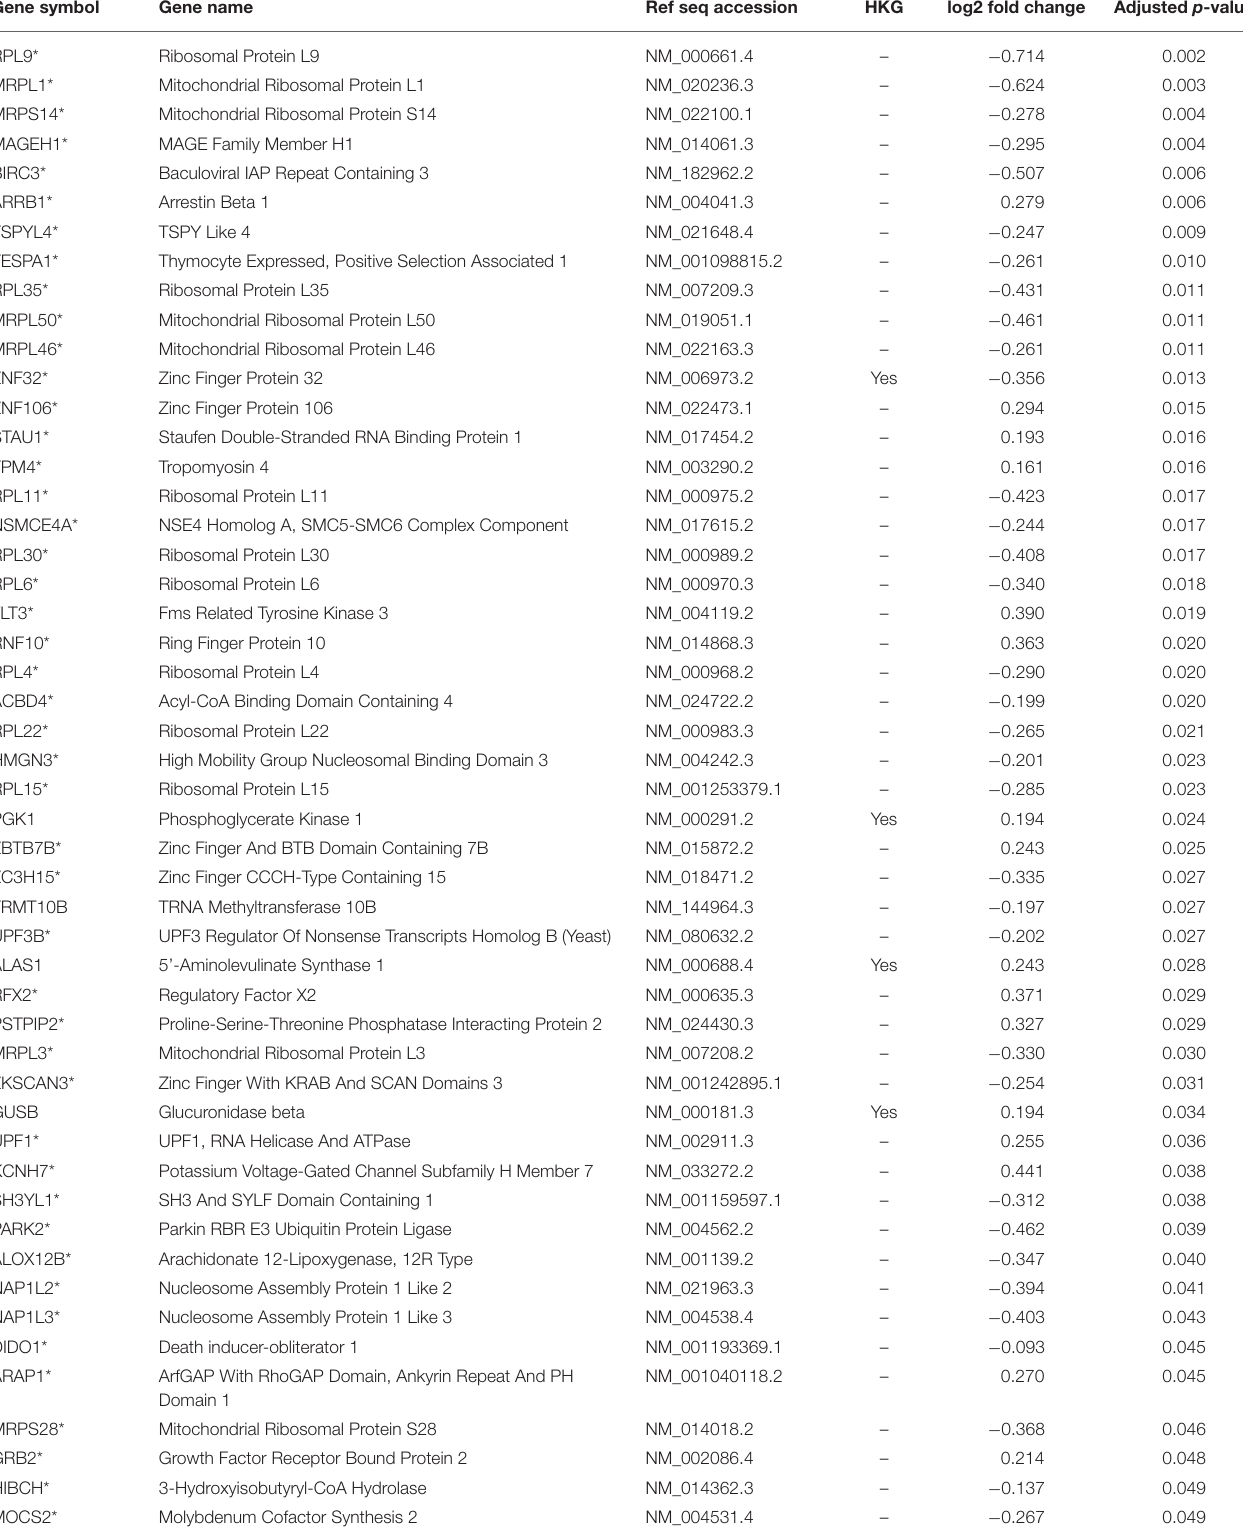
TABLE 2 | Genes included in the cell death and survival